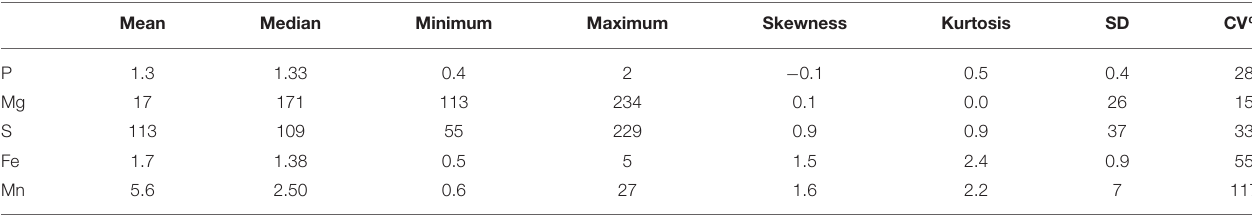
TABLE 2 | Selected plant available nutrients (mg kg − 1 dry soil) in the surface soil of a rewetted peatland. Mean